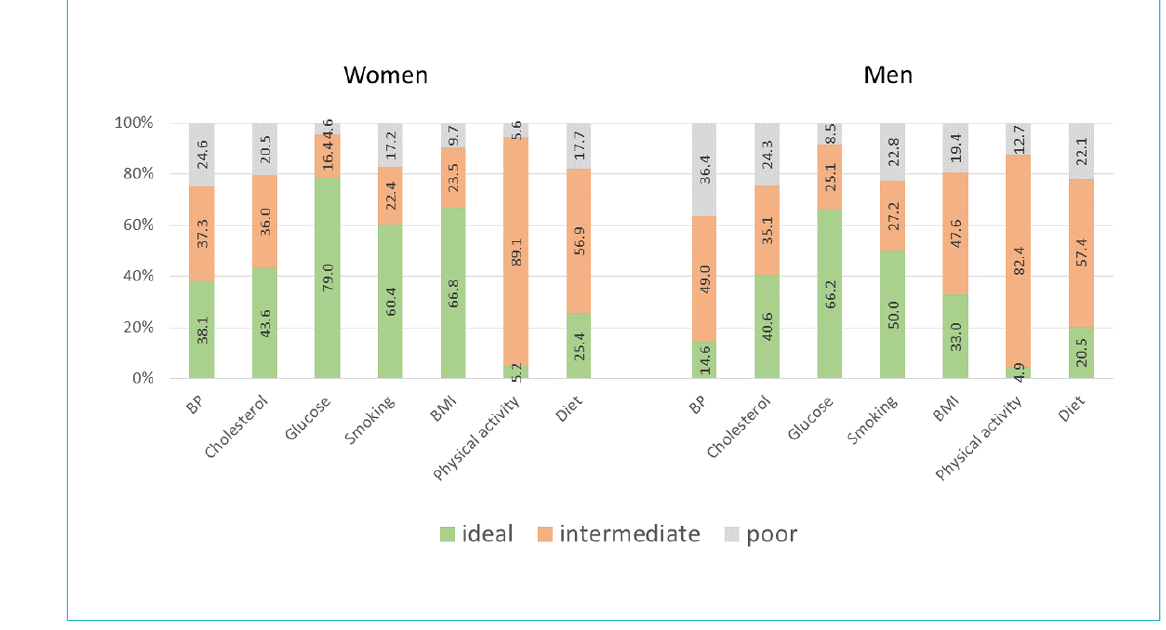
Figure 1: Prevalence of the three levels (ideal, intermediate and poor) for all seven health metrics of the American Heart Association separate for women and